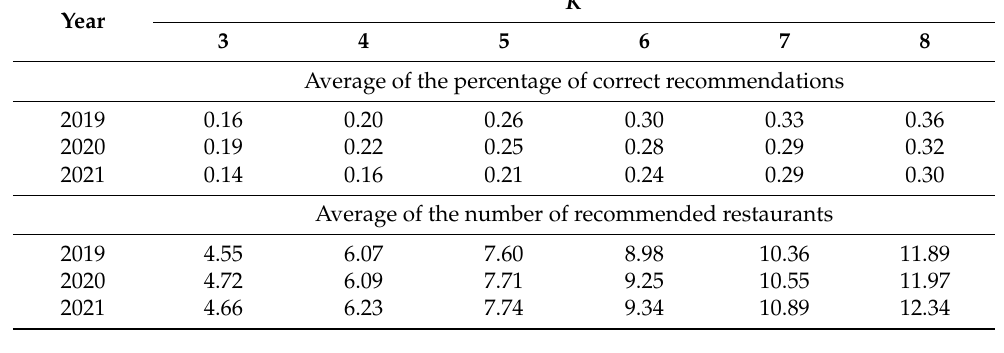
Table 5. Results of our proposed recommendation system according to the value of the parameter k .